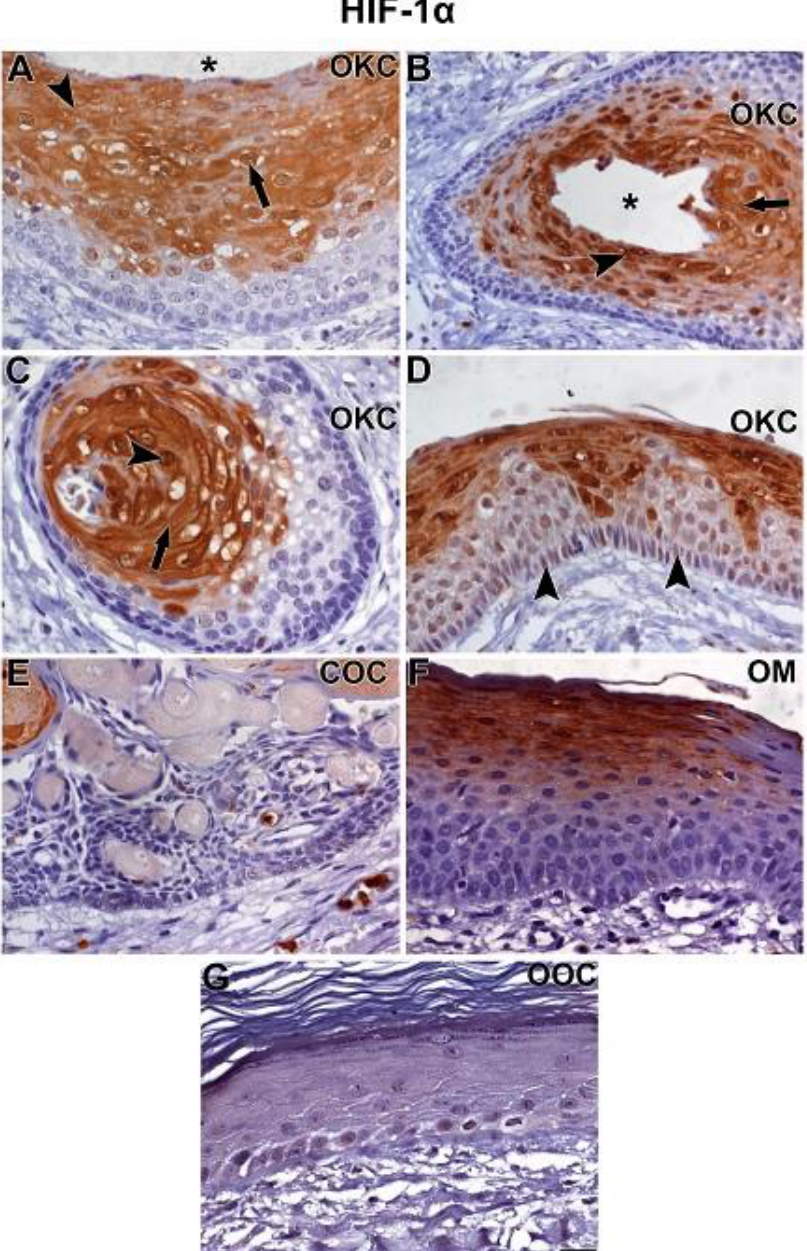
Figure 2. Immunolabelling of HIF-1 α in OKC ( A – D ), COC ( E ), OM ( F ), and OOC ( G ). HIF-1 α immunoexpression showed strong nuclear ( A and B , arrow) and cytoplasmic ( A and B , arrowhead) staining in OKC, mainly in the epithelial layers near to the cyst lumen ( A , asterisk) and in areas of cyst formation ( B , asterisk). In the center of epithelial islands formed by the odontogenic epithelium, the so-called pupal cysts, intense cytoplasmic ( C , arrow) and nuclear ( C , arrowhead) staining was seen. Weak nuclear but not cytoplasmic staining was found in basal layer cells ( D , arrowheads). COC exhibited a very weak HIF- 1α expression in a few parabasal cells. Staining in the basal layer was very weak and in a few selected cells. ( E ) HIF- 1α expression in OM appeared to be stronger than in COC but still weaker than in OKC. The pattern of HIF- 1α expression was more similar to that seen in OKC, where staining intensity increased towards upper cells of the parabasal layers. HIF-1 α expression in OOC was very weak, observed in selected basal and suprabasal cells ( G ). Scale bar: 20 µ